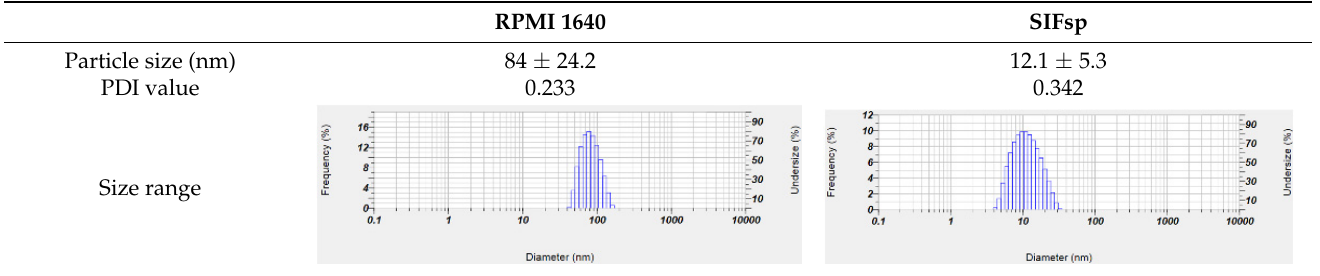
Figure 2. Solubility and drug degradation of CLT. ( A ) CLT solubility in oleic acid (OA), Tween 80 (TW80), and polyethylene glycol 400 (PEG 400). ( B ) Two-month chemical degradation curve of CLT in F35 at 25 and 40 °C. Each value represents the mean ± standard deviation from three independent experiments. **** p < 0.0001 as compared to CLT solubilized in OA. ## p < 0.01 as compared to CLT solubilized in TW80. Table 1. Micrometric properties of CLT-loaded F35 after self-emulsifying in RPMI 1640 and SIFsp medium.